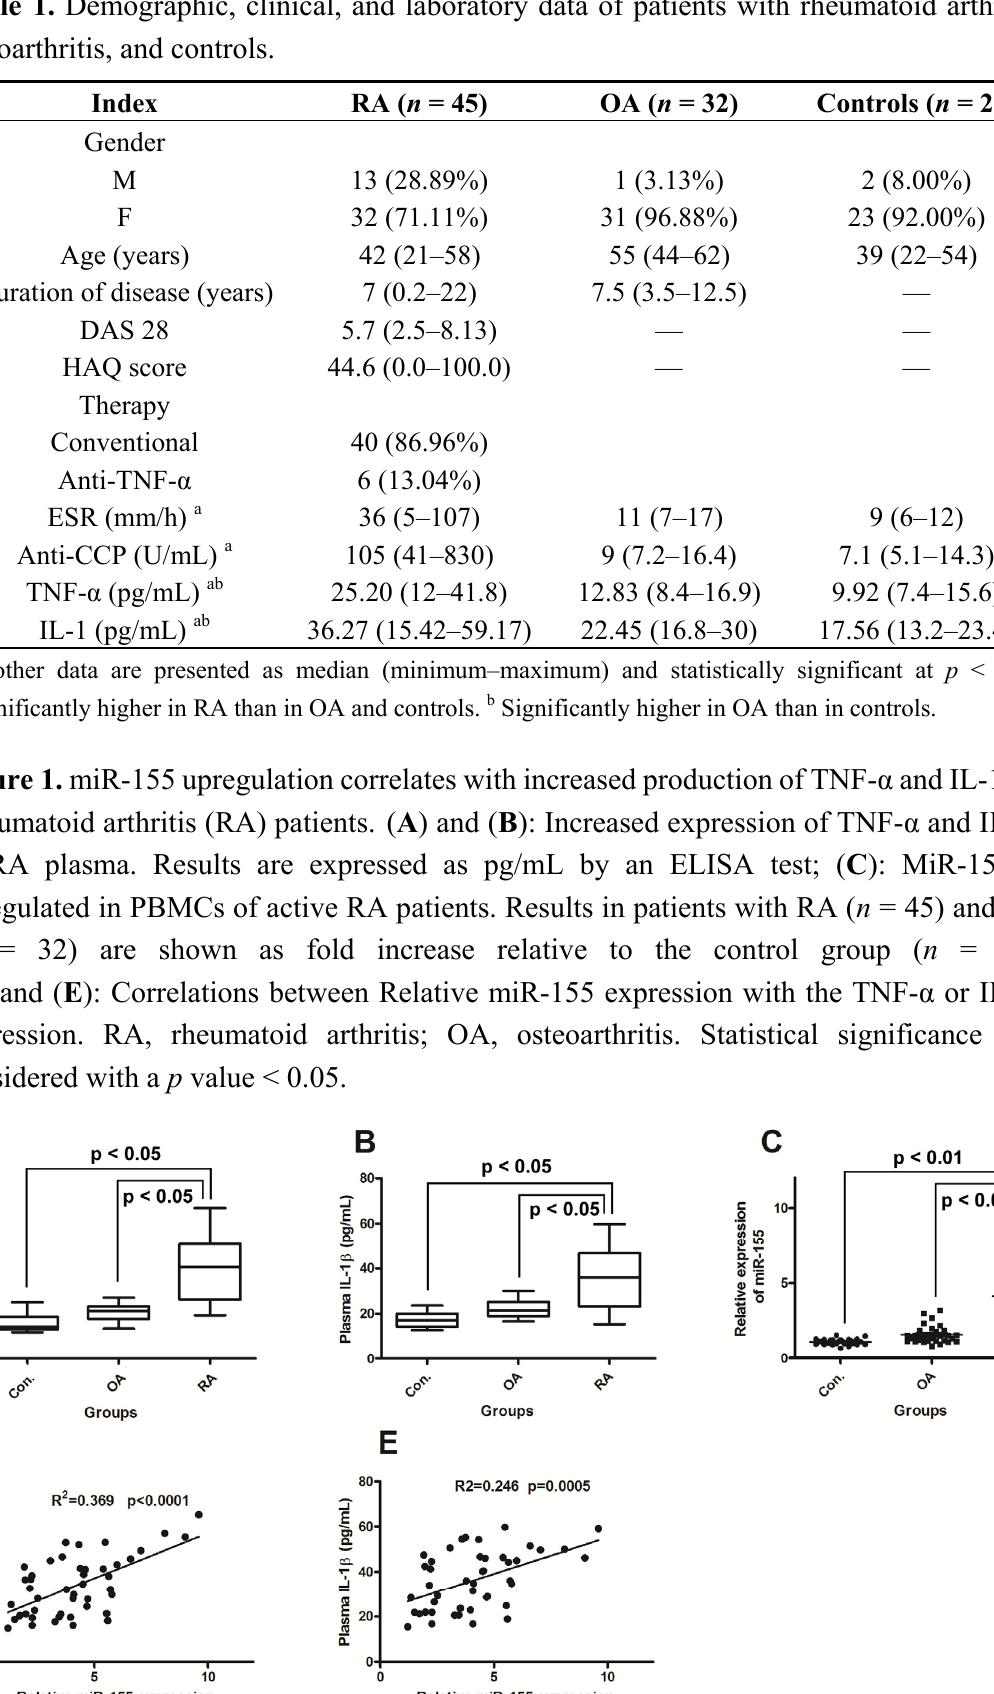
Table 1. Demographic, clinical, and laboratory data of patients with rheumatoid arthritis, osteoarthritis, and controls.